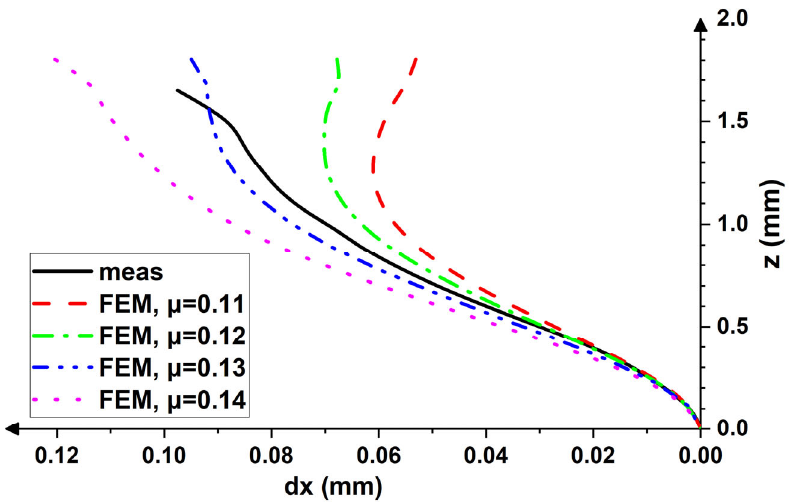
Figure 12. Experimental and simulated displacement patterns across the half-thickness of symmetri- cally rolled sheet.